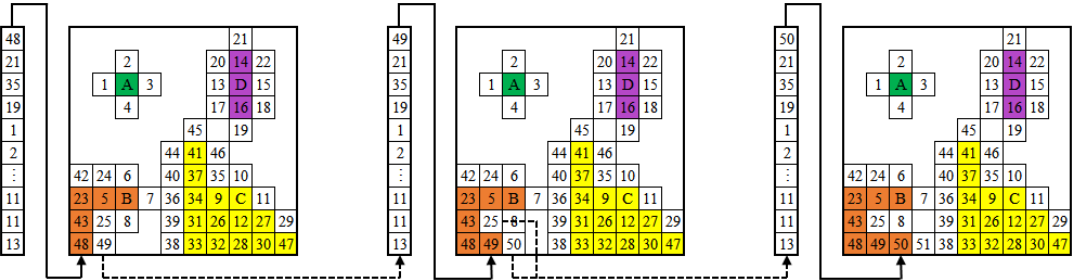
Figure 4. Detailed local inspecting and labeling processes from 48th to 50th sequentially of SNIC. Solid arrows stand for popping and labeling in corresponding label maps, while dotted arrows represent inspecting and pushing for the next step.